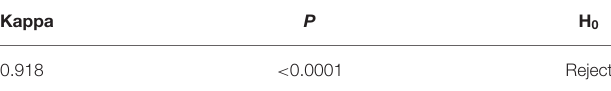
TABLE 5 | Results of Kappa consistency